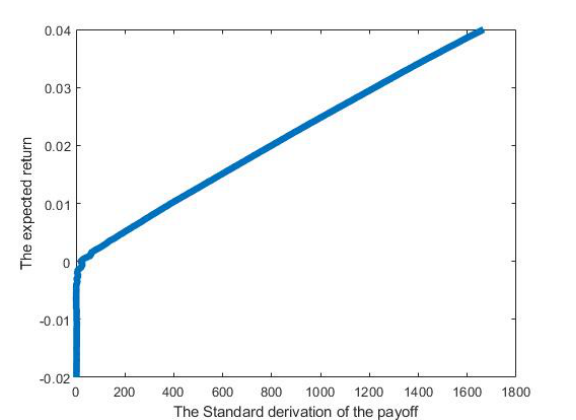
Figure 3. The coefficient frontier of the variance minimization.